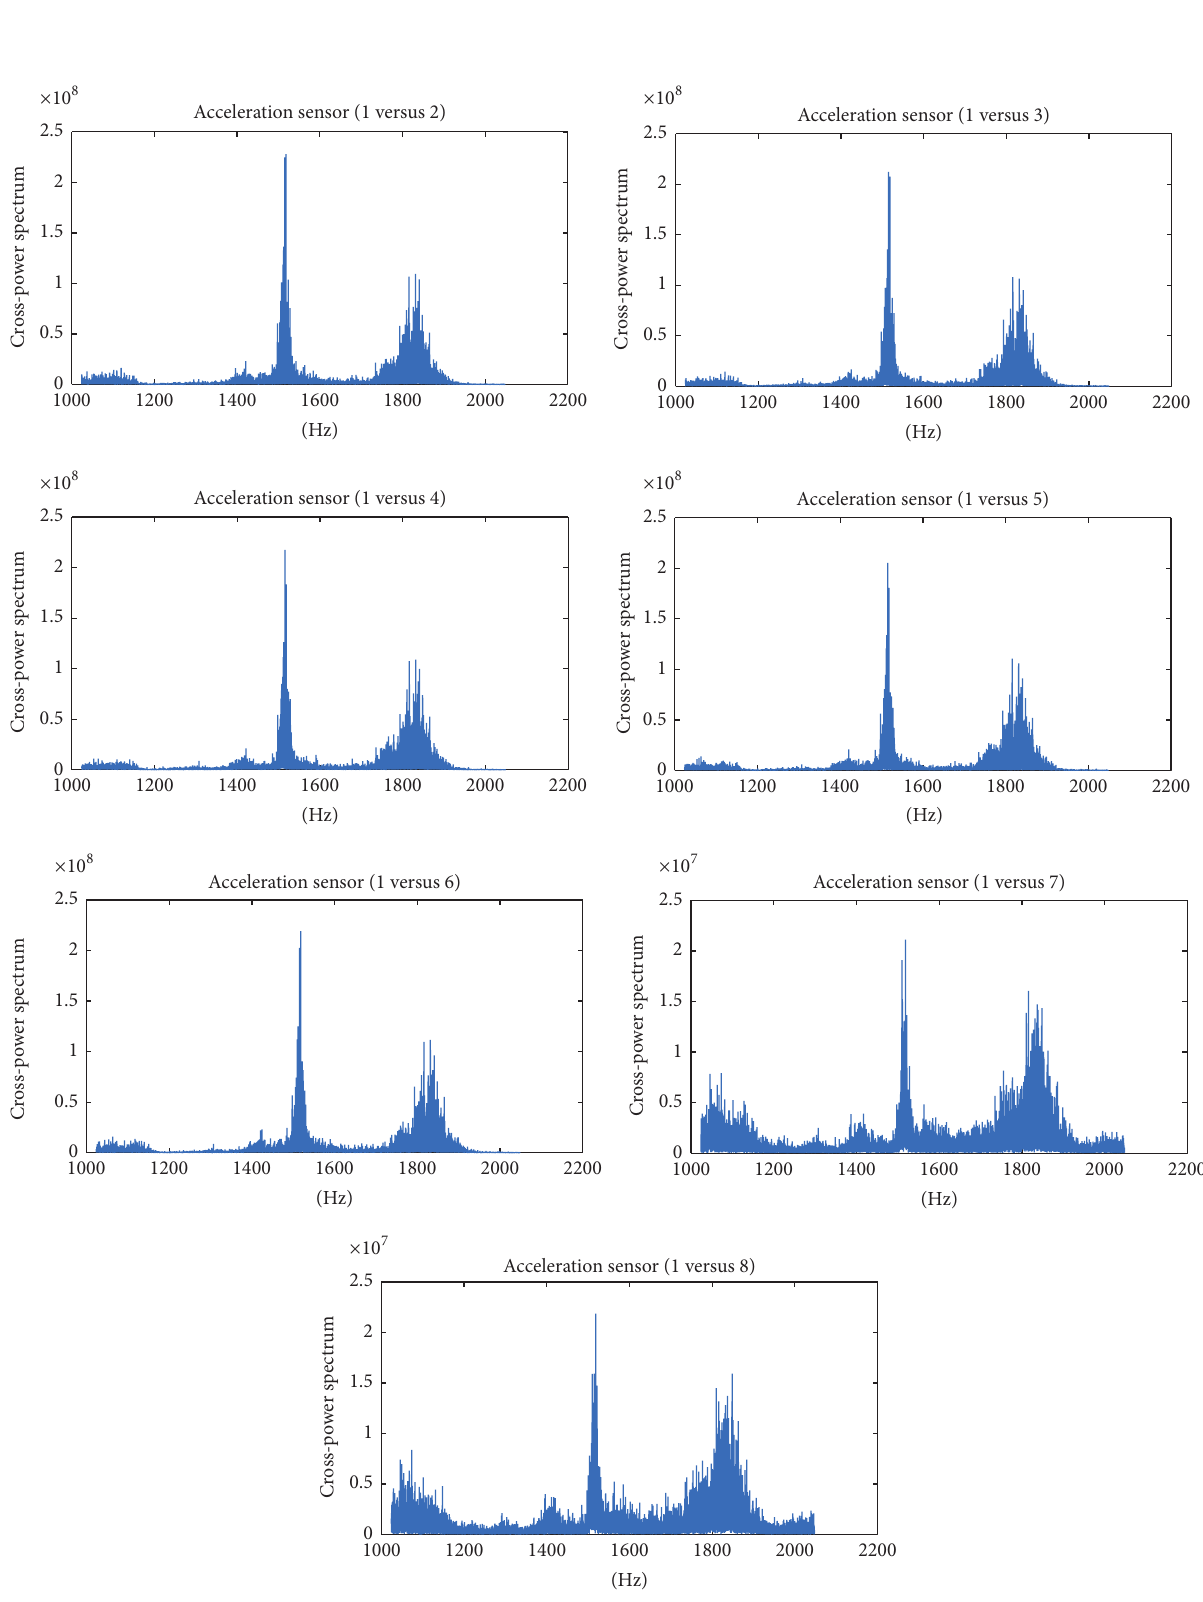
Figure 6: Cross-power spectrum density